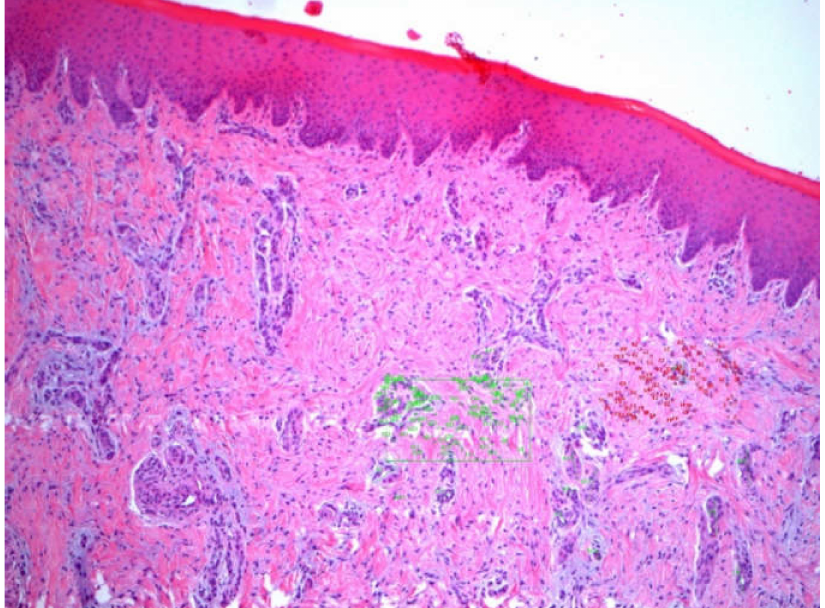
Figure 5. Two areas of 35,000 µ m 2 (green and red) on which the cells present were counted can be seen (100 × ).